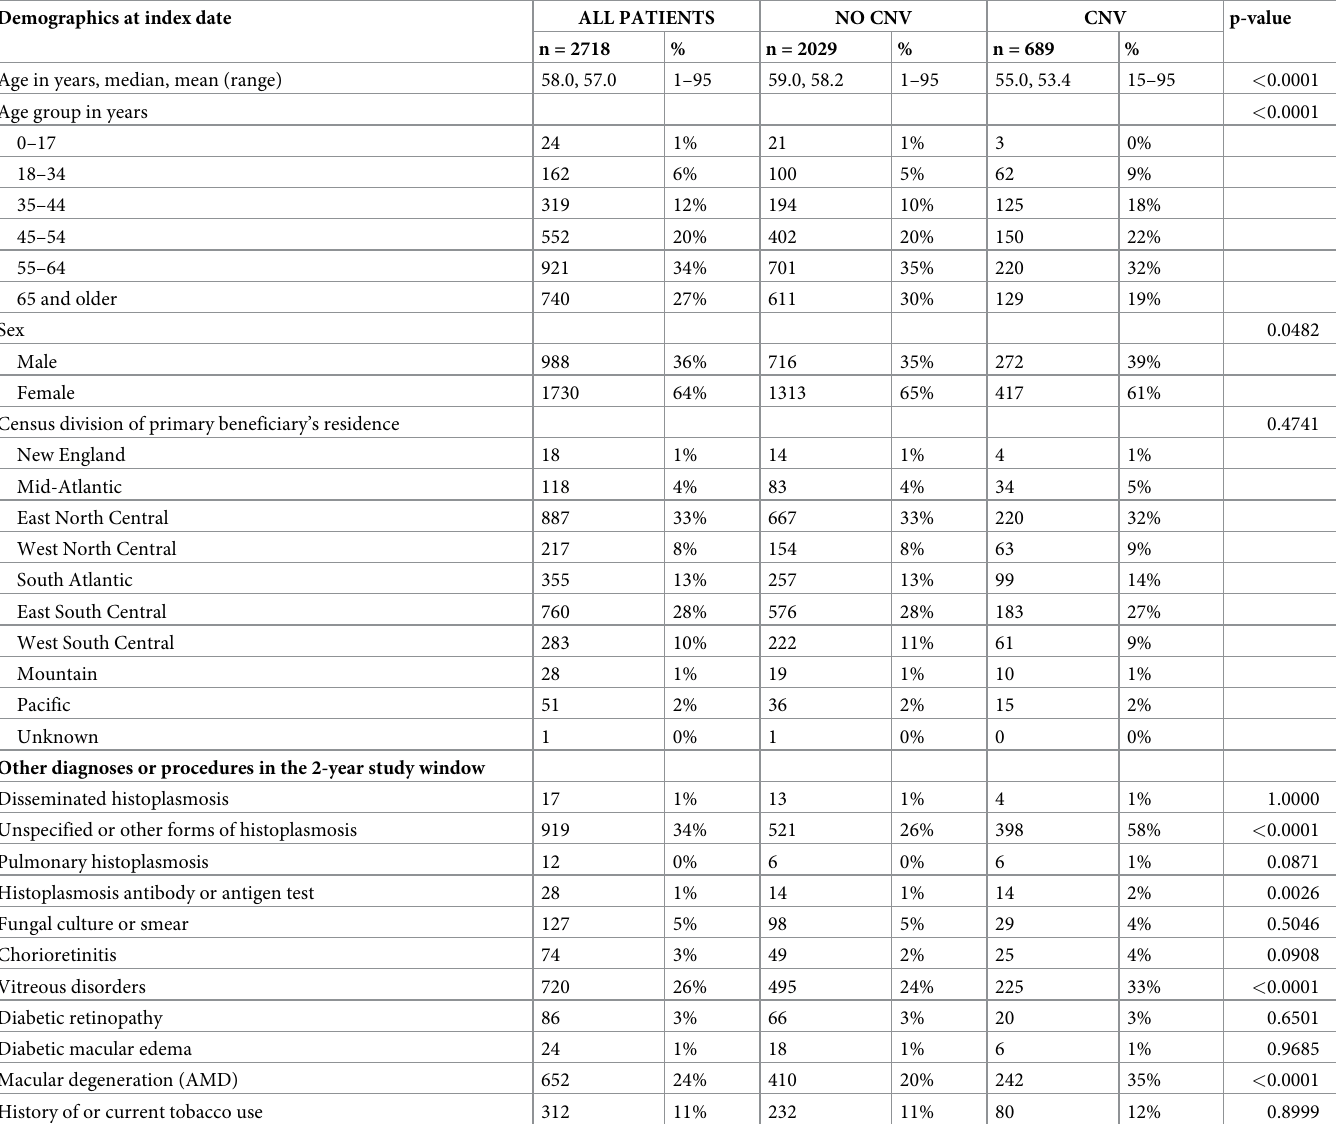
Table 1. Demographic features and specific diagnoses or procedures among patients with presumed ocular histoplasmosis syndrome,